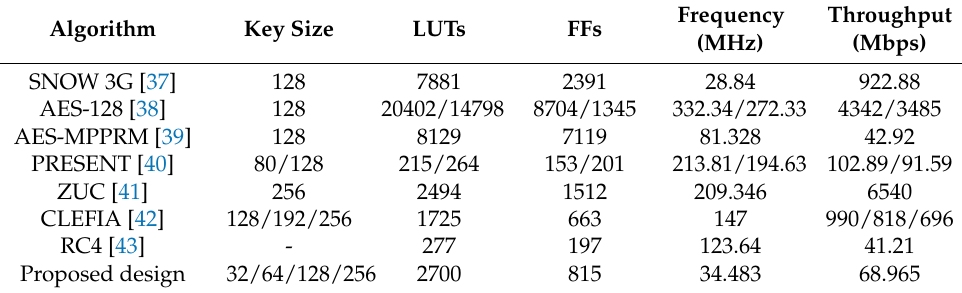
Table 4. Performance comparisons from the literature.